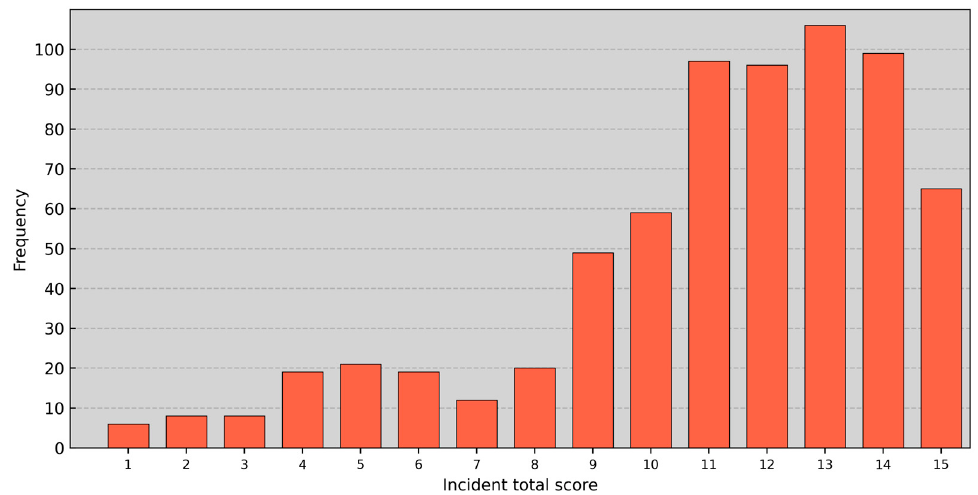
Figure 6. Frequency distributions of each total score for incidents exceeding statewide ROS break- point; all states 1999–2014. point; all states